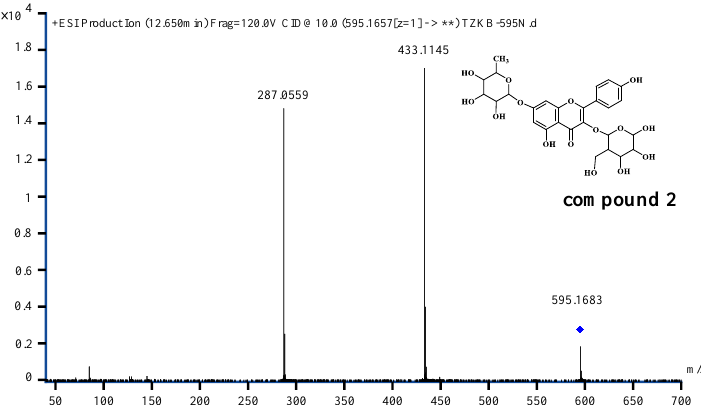
Figure 3. PIMS of kaempferol 3-O-glucoside 7-O-rhamnoside (compound 2 ). The blue sign was used to mark the precursor ion.